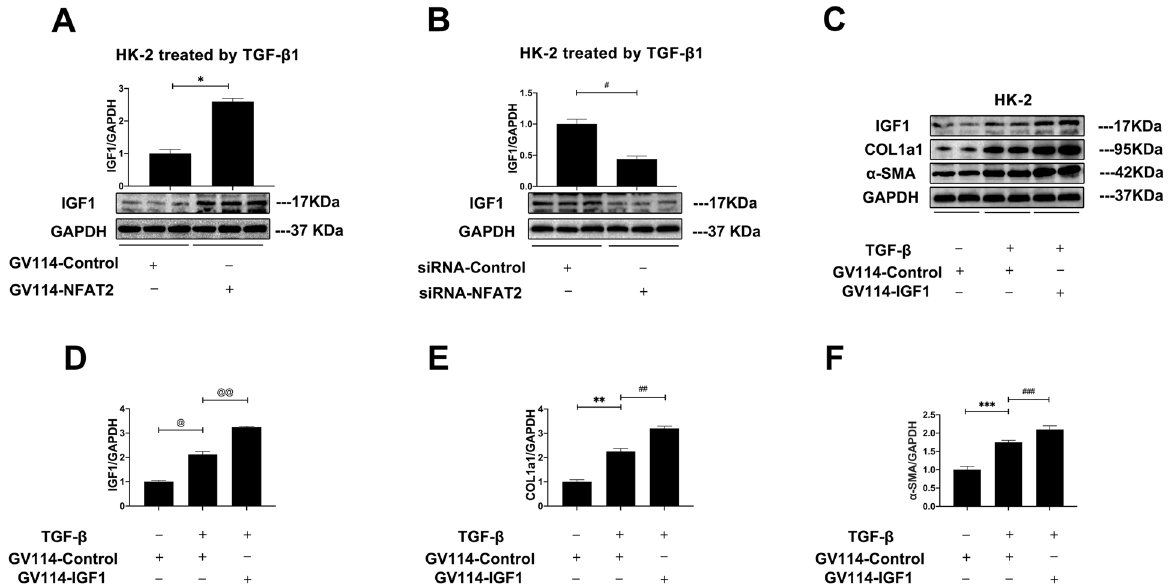
Fig. 7 IGF1 was regulated by NFAT2 and was essential for accumulation of ECM in renal fi brosis. A , B The protein levels of IGF1 and GAPDH; C Representative blots of IGF1, COL1a1, α -SMA, and GAPDH; D IGF1/GAPDH ratio; E COL1a1/GAPDH ratio; F α -SMA /GAPDH ratio; * p < 0.05, ** p < 0.05, *** p < 0.05, # p < 0.05, ## p < 0.05, ### p < 0.05, @ p < 0.05, @@ p < 0.05, as indicated. The results are expressed as the mean ± standard error of the mean (S.E.M.) for 3 – 4 independent